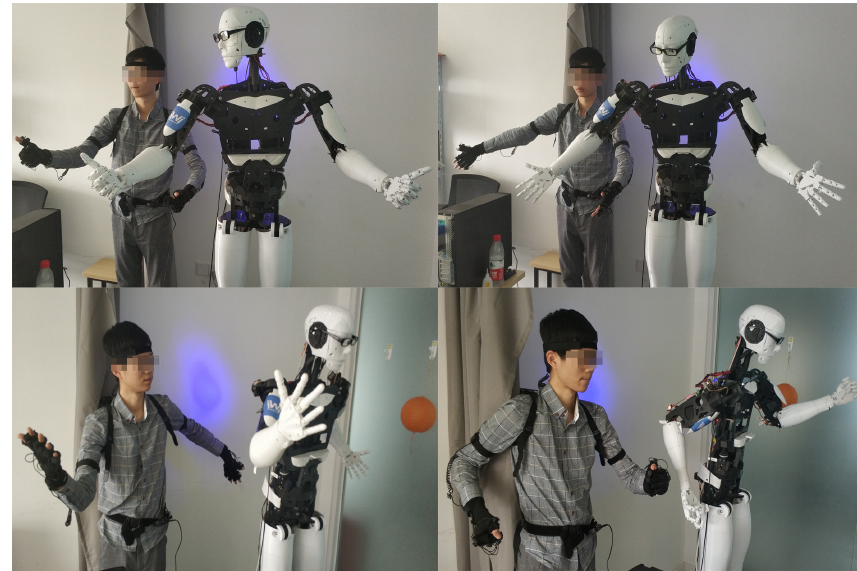
Figure 12. Experiments of different gestures with arms and